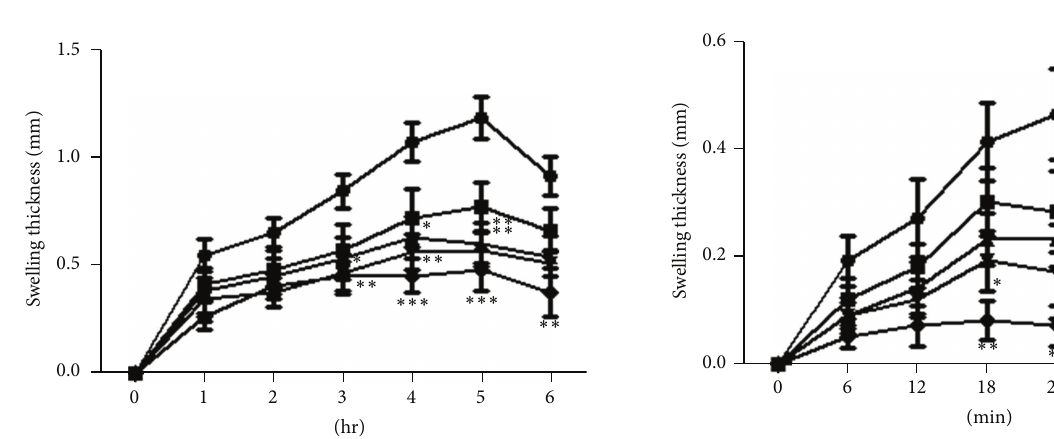
Figure 3: Inhibitory effect of patulitrin on carrageenin-induced hind-paw edema in mice. Drugs were administered p . o . 30 min